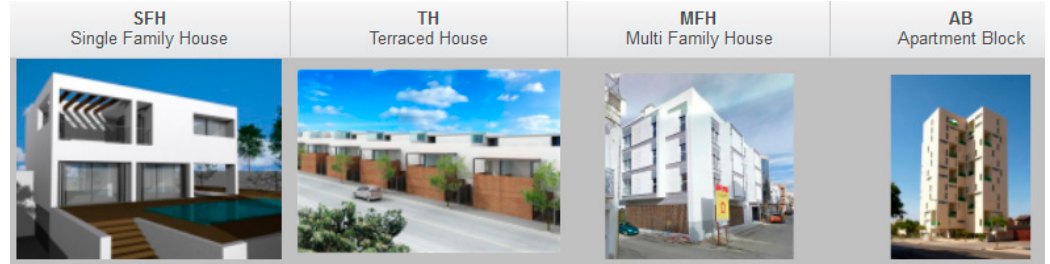
Figure 3. Exemplary building typologies for Spain from 2001 to 2016 divided in four typologies by TABULA WebTool [21]. TABULA WebTool